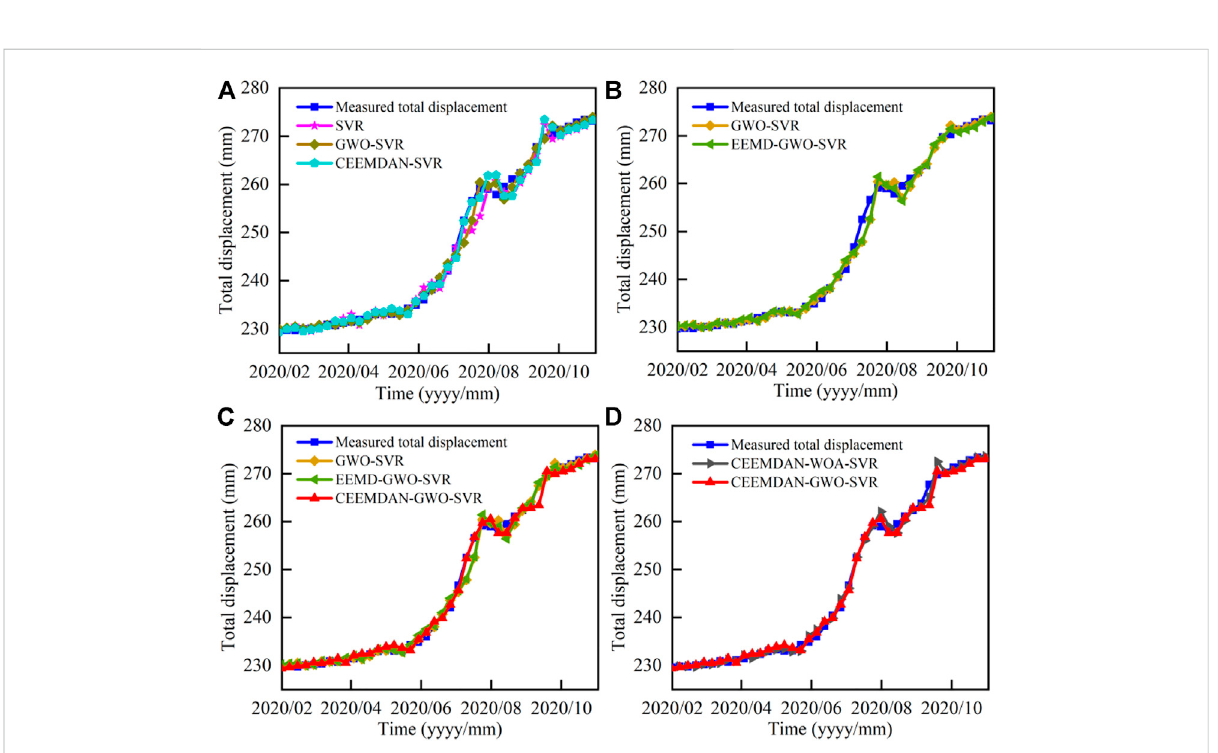
FIGURE 11 Prediction and comparison between different models. (A) Comparison of GWO-SVR, CEEMDAN-SVR and SVR models; (B) Comparison of GWO-SVR and EEMD-GWO-SVR models; (C) Comparison of GWO-SVR, EEMD-GWO-SVR and CEEMDAN-GWO-SVR models; (D) Comparison of CEEMDAN-WOA-SVR and CEEMDAN-GWO-SVR